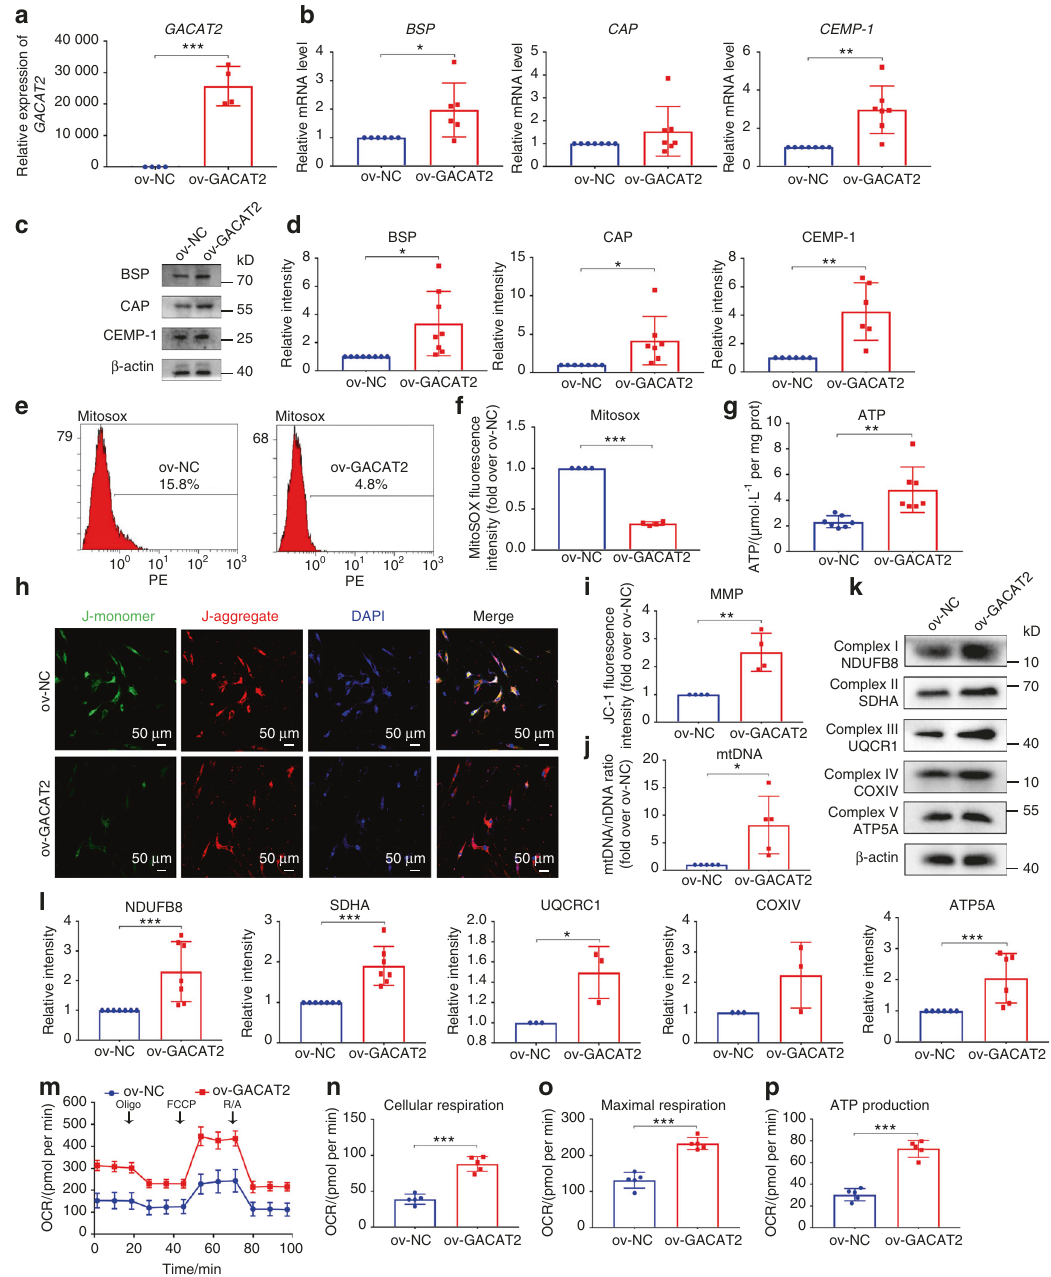
Fig. 5 Overexpression of GACAT2 (ov- GACAT2 ) reverses the in fl ammation-compromised cementoblastic differentiation and mitochon- drial function of PDLSCs. The cells were incubated in medium with both in fl ammatory cytokines and EMD (in fl ammatory environment). a Overexpression ef fi ciency of GACAT2 in PDLSCs validated by qRT-PCR. b Relative cementoblastic differentiation-related gene expression levels of BSP , CAP and CEMP-1 determined by qRT-PCR. c Relative cementoblastic differentiation-related protein expression of BSP, CAP and CEMP-1 determined by Western blots. d Semiquantitative analysis of protein expression levels (normalized to β -actin) in terms of relative gray density. e mtROS levels in PDLSCs determined with the aid of a MitoSOX probe ( fl ow cytometric analysis). f Quanti fi cation of mtROS levels (re fl ected by the relative fl uorescence intensity of MitoSOX). g Intracellular ATP contents (ATP assay). h The MMP was determined with a JC-1 probe (immuno fl uorescence staining; scale bar: 50 μ m). i Quanti fi cation of MMP levels (re fl ected by the relative ratio of red/green fl uorescence intensity of JC-1). j mtDNA content determined by qRT-PCR. k Relative mitochondrial complex-related protein expression of NDUFB8 (subunit of complex I), SDHA (subunit of complex II), UQCRC1 (subunit of complex III), COXIV (subunit of complex IV) and ATP5A (subunit of complex V) determined by Western blots. l Semiquantitative analysis of protein expression levels (normalized to β -actin) in terms of relative gray density. m OCR of PDLSCs determined by a Seahorse Bioscience XF Analyzer; arrows indicate the sequential injection of 1 μ mol·L − 1 Oligo, 1 μ mol·L − 1 FCCP and 2 μ mol·L − 1 R/A. n Quanti fi cation of cellular respiration (basic OCR value prior to Oligo injection). o Quanti fi cation of maximal respiration (differences between the maximum rate measurement after FCCP injection and the minimum rate measurement after R/A injection). p Quanti fi cation of ATP production (difference between the fi nal rate measurement prior to Oligo injection and the minimum rate measurement after Oligo injection). The data are shown as the mean ± SD for n from 3 to 8; * P < 0.05, ** P < 0.01 and *** P < 0.001 indicate signi fi cant differences between the indicated